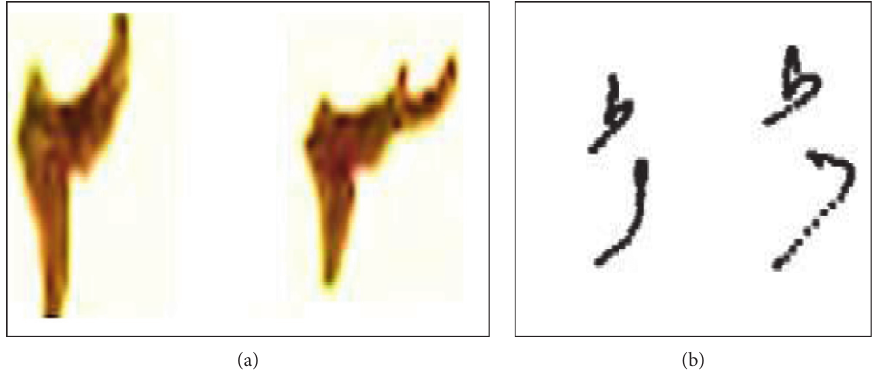
Figure 2: Similarity among Urdu characters and